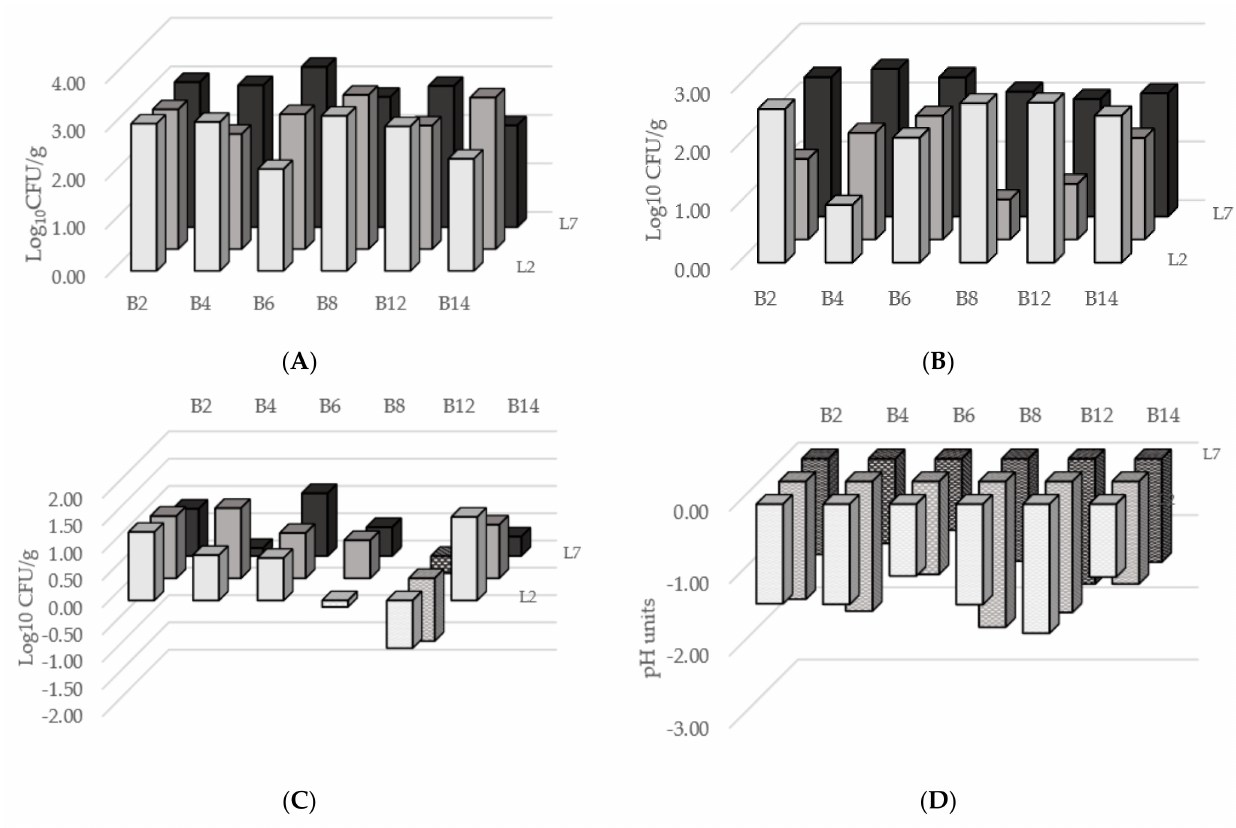
Figure 1. Change of LAB ( A ), yeasts ( B ) and bacterial contaminants ( C ) as difference in log CFU/g plate counts and change of pH ( D ) during the fermentation in microcosms inoculated with different pairs of LAB and yeast